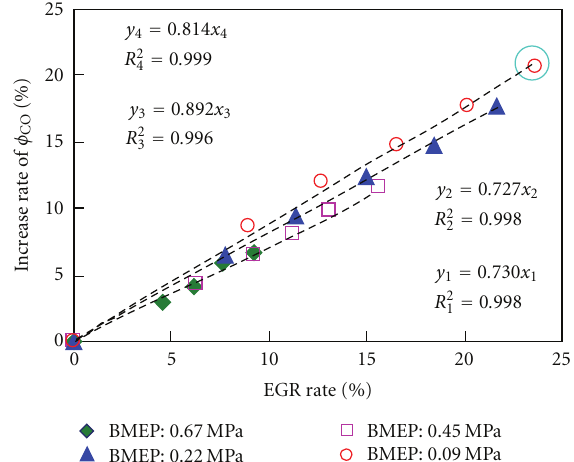
Figure 9: The CO volumetric concentration increasing feature with EGR rate.